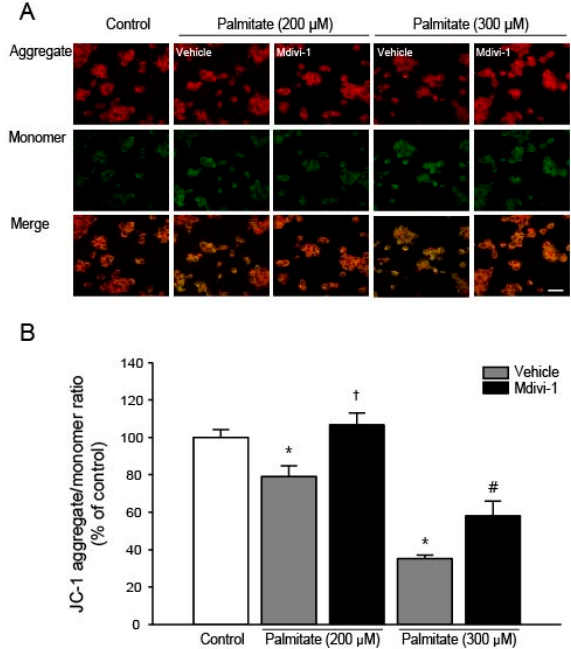
Figure 4. Effect of mdivi-1 on mitochondrial transmembrane potential in hippocampal NSCs exposed to palmitate insult. Cells were pretreated with DMSO vehicle or mdivi-1 (20 μ M) for 2 h and then exposed to 0.5% BSA vehicle or palmitate (200 and 300 μ M) for 24 h. ( A ) The mitochondrial transmembrane potential was determined by confocal microscopy using JC-1 dye. Mitochondria with a higher membrane potential have a red fluorescence, and those with a lower membrane potential are green. Scale bar = 20 μ m. ( B ) The ratio of red-to-green fluorescence was quantified in cells of interest using the measurement functions in the Carl Zeiss LSM 700 Meta software. Values are the mean ± SEM expressed as percent of control. * p < 0.05 vs. DMSO-treated control; † p < 0.05 vs. 200 μ M palmitate; # p < 0.05 vs. 300 μ M palmitate.